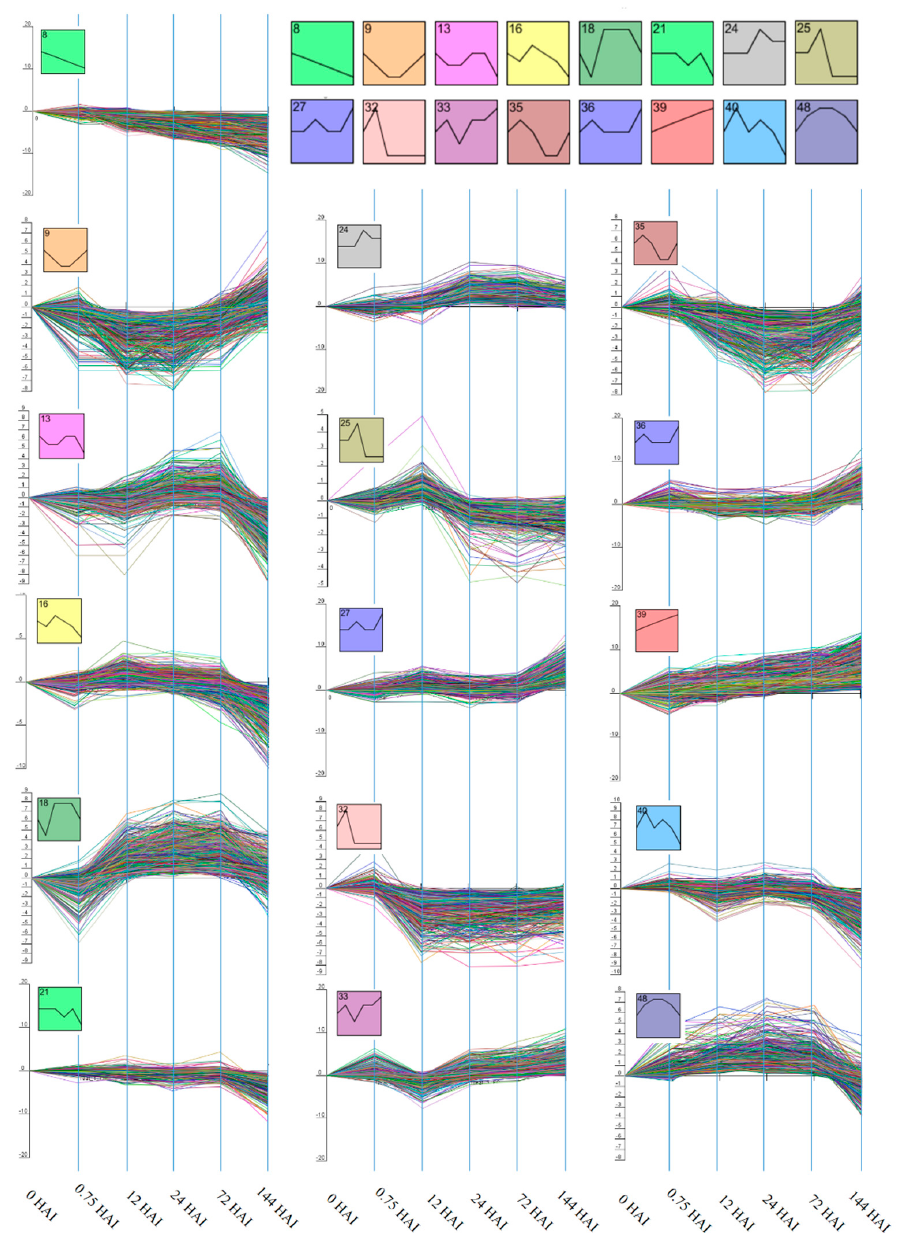
Figure 1. Poplar transcripts grouped according to temporal expression profiles. Differentially expressed genes obtained from RNA-Seq transcriptome studies were divided into 16 distinct significant temporal profiles using STEM software. Each of the profiles is represented in a different plot, having mean expression ratios (log2) for each of the assigned transcripts at each time point.